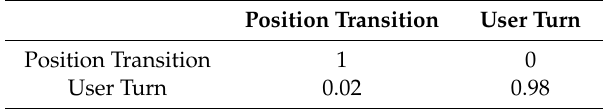
Table 2. Confusion table for discrimination between position transitions and user turns.